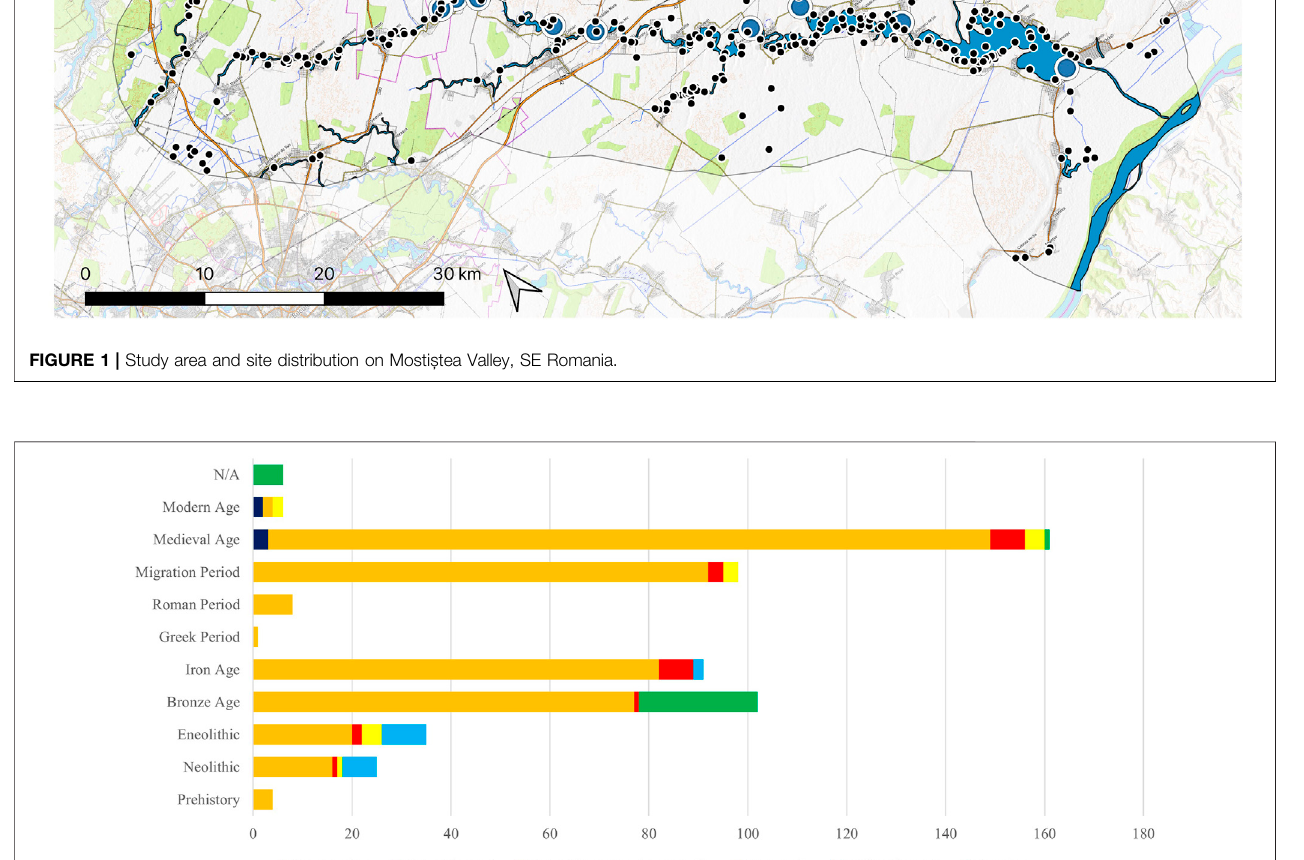
Frontiers in Environmental Science |